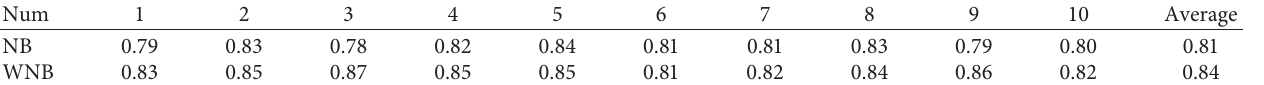
From Table 3, the classification accuracy comparison between NB algorithm and WNB algorithm is graphically depicted in Figure 5 .